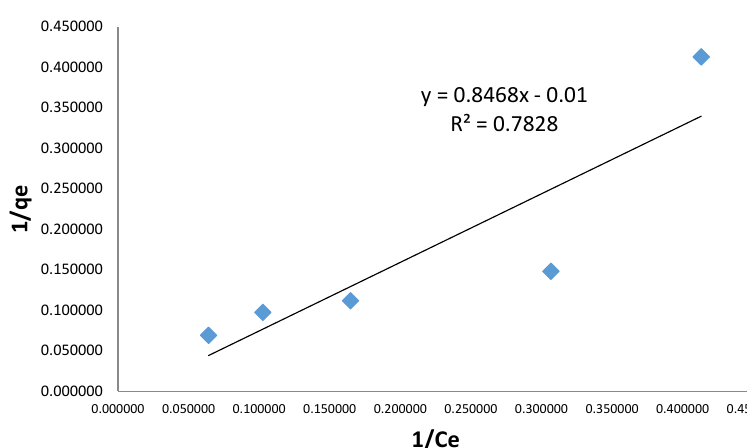
Figure 9. Langmuir isotherm of adsorption of methyl orange by the adsorbent